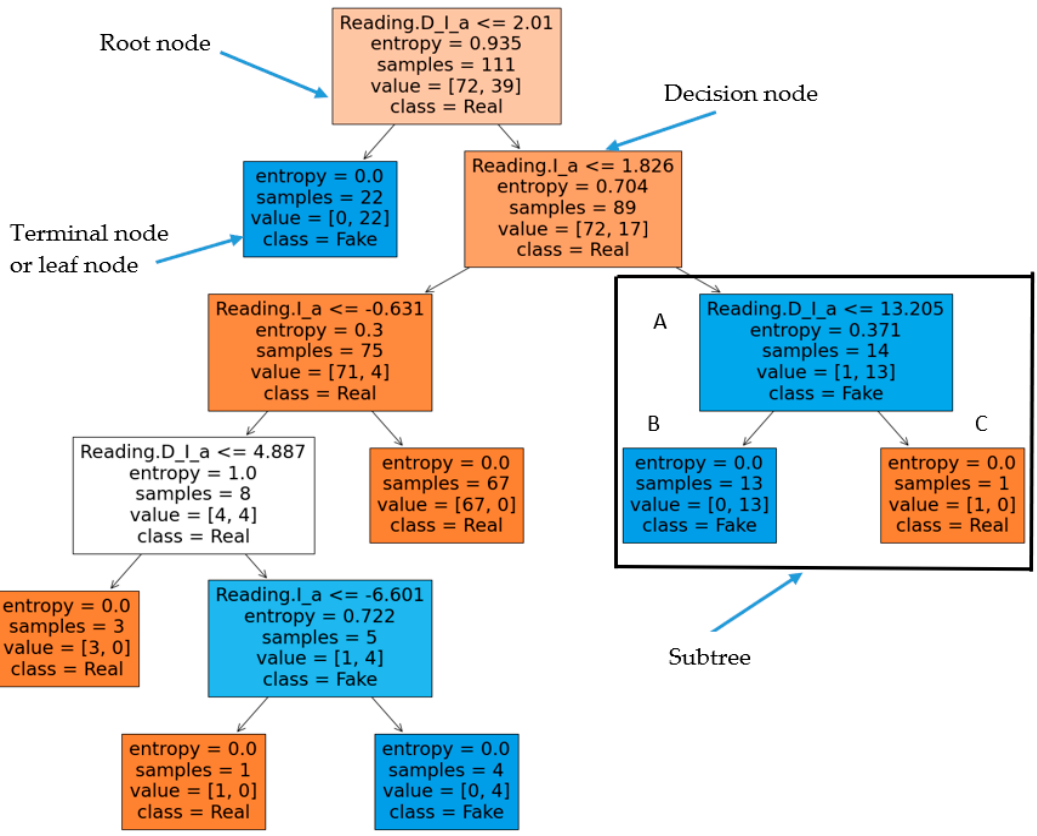
Figure 7. Identification of smart meter reading into real and fake data by decision tree algorithm.